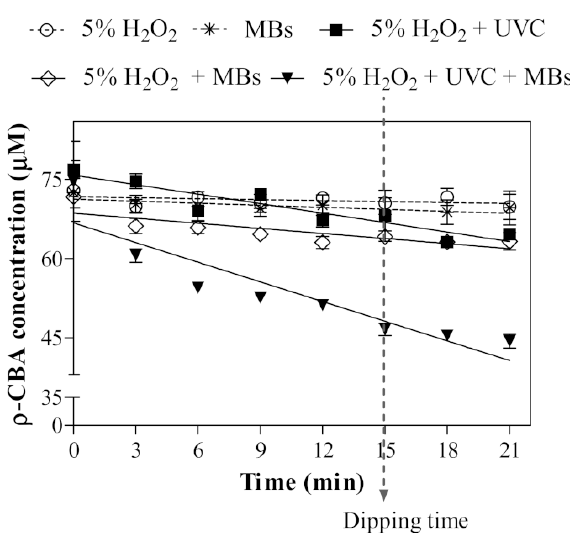
Figure 3. Changes in para -chlorobenzoic acid ( ρ -CBA) concentration over time in different treatments. The dotted line indicated non-significant different regression relationship. (5% H 2 O 2 : y = 71.73, R 2 = 0.04; MBs: y = 71.27, R 2 = 0.06; 5% H 2 O 2 + UV-C: y = − 0.60x + 75.83, R 2 = 0.61: 5% H 2 O 2 + MBs: y = − 0.32x + 68.63, R 2 = 0.51; 5% H 2 O 2 + UV-C + MBs: y = − 1.24x + 71.27, R 2 = 0.70). H 2 O 2 = hydrogen peroxide, MBs =